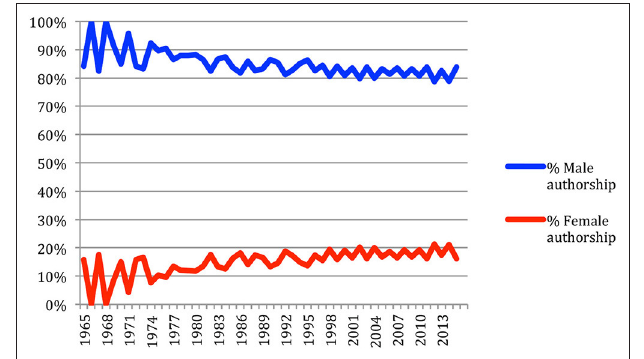
FIGURE 27 | Gender of the authors’ contributions over time.